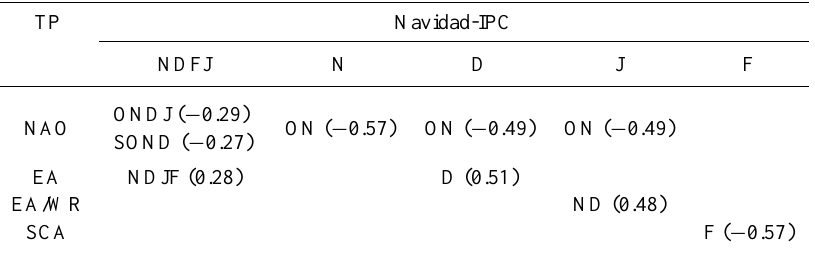
Table 3. Significant correlations (99% level) between the monthly IPC-Navidad time series and the Northern Hemisphere teleconnection patterns (TP). Significant correlations are observed for the NAO, EA, EA/WR and SCA patterns; and for different combinations of